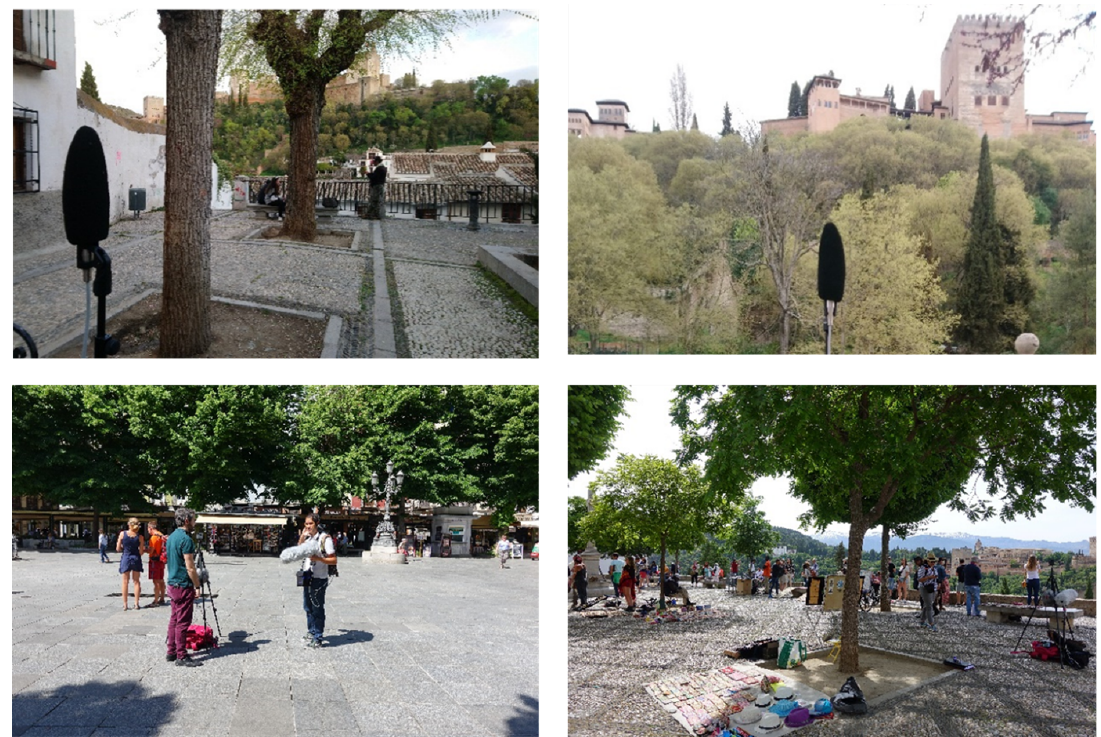
Figure 1: From left to right and from top to bottom Placeta de Carvajales (CAR), Paseo de los Tristes (PLT), Plaza de Bib-Rambla (BIB) and Plaza de San Nicolás (SNC). Own resource (2019)